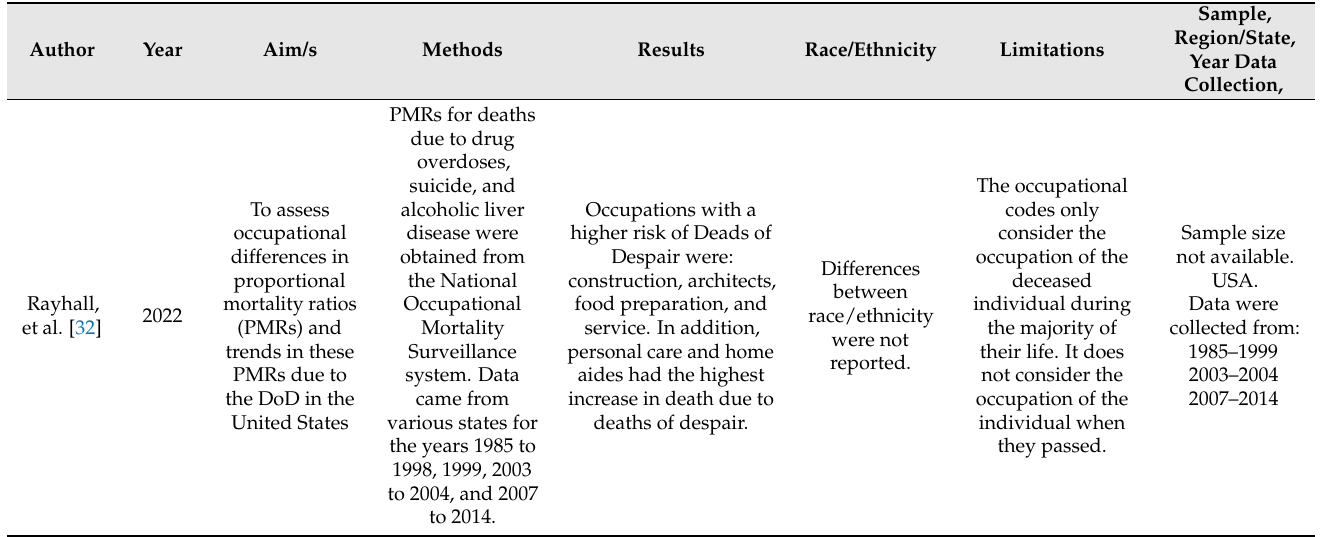
Table 2. Studies addressing Deaths of Despair according to occupational